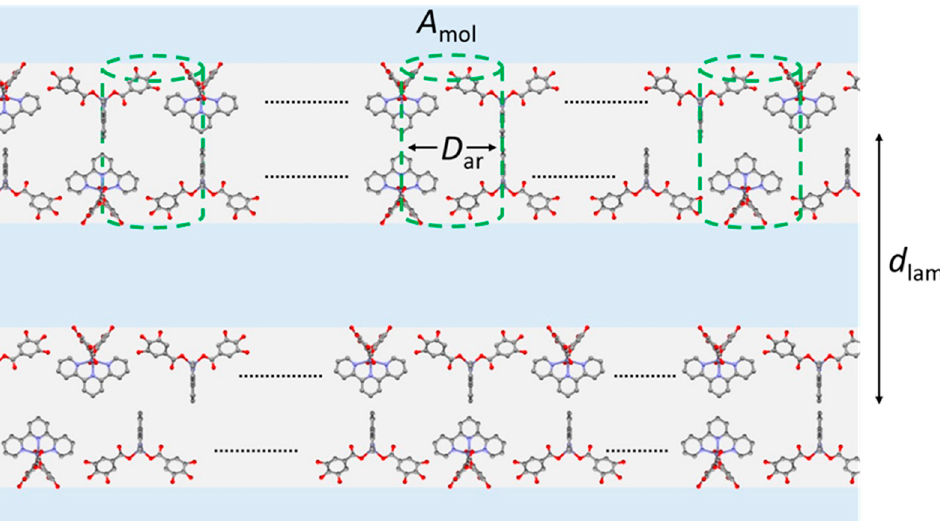
Figure 3. Idealized supramolecular representation of the Zn_tpy complexes in the SmA phase through self-assembly of aromatic and metallic moieties into monolayers (various possibilities of head-to-head arrangements are shown, with, in some cases, the possibility of larger interdigitation) alternating with molten chains (aliphatic chains continuum is shown in pale blue); d lam and A mol are the lamellar periodicity and molecular area, and Dar is the average separation between [ Zn_tpy ] moieties, D ar ~ √ ( A mol / π ) (see Table 2). Table 2. Geometrical mesophases